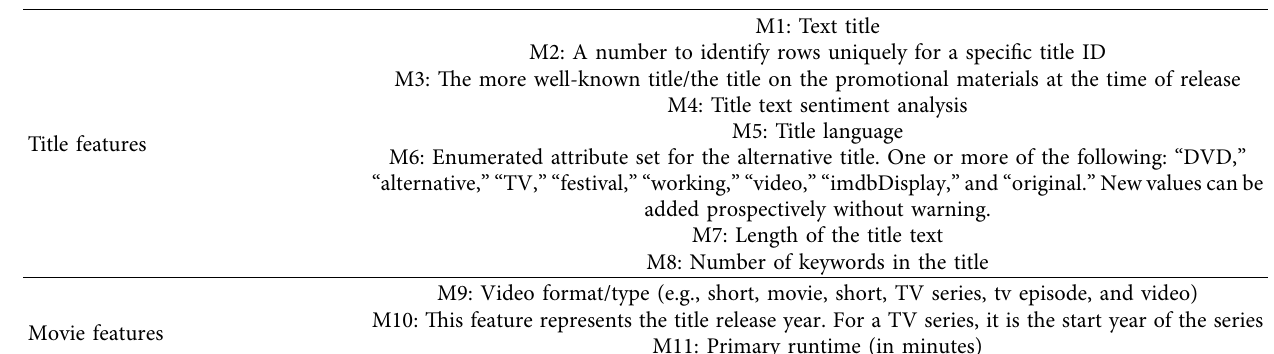
Table 3: The dataset’s selected features